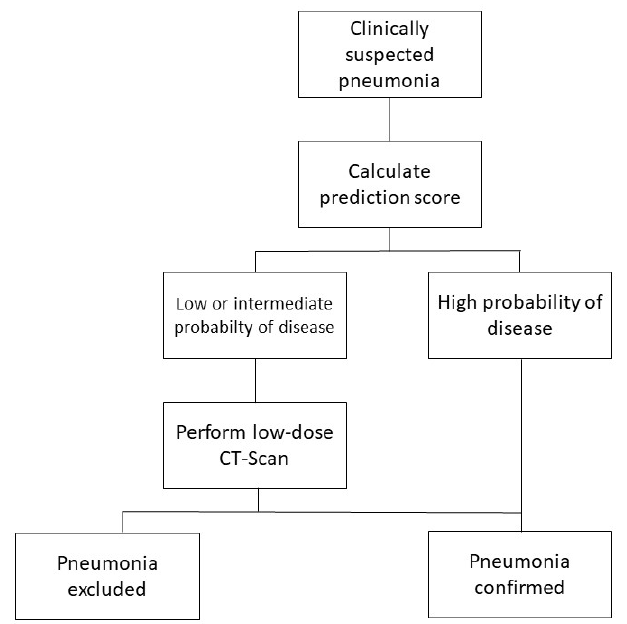
Figure 1. Algorithm to guide low-dose computed tomography scan (LDCT) performance.